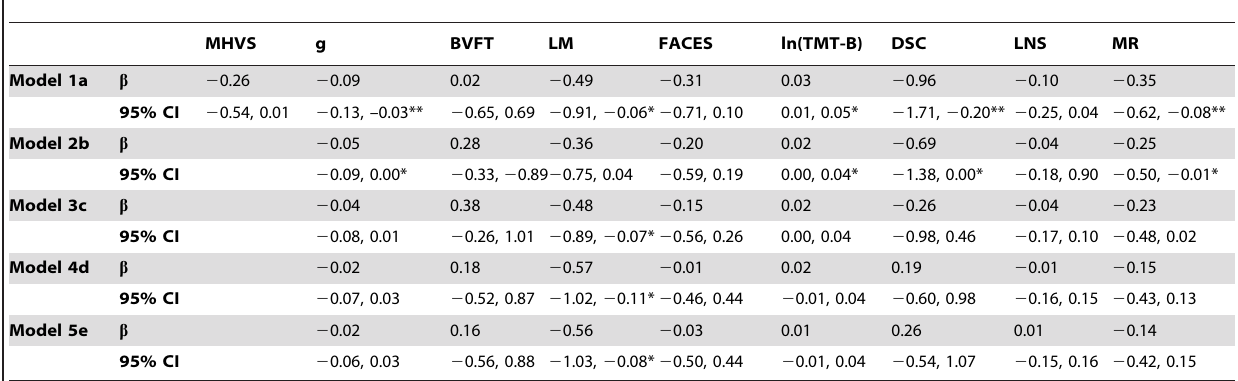
Table 3. Multivariate associations between NT-proBNP and cognitive test